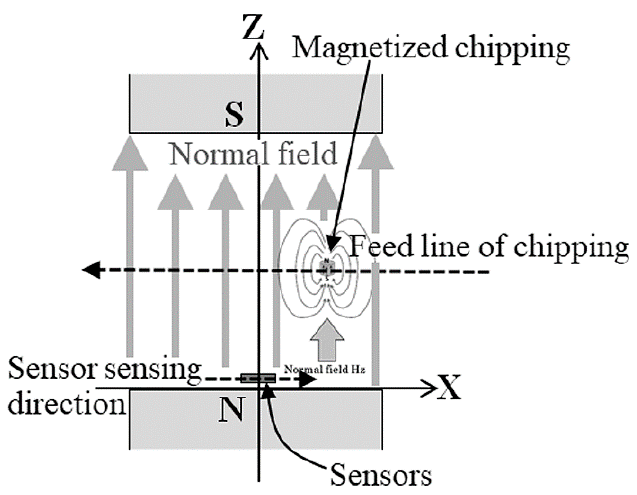
Figure 4. Side view of the structure of the position estimation system.